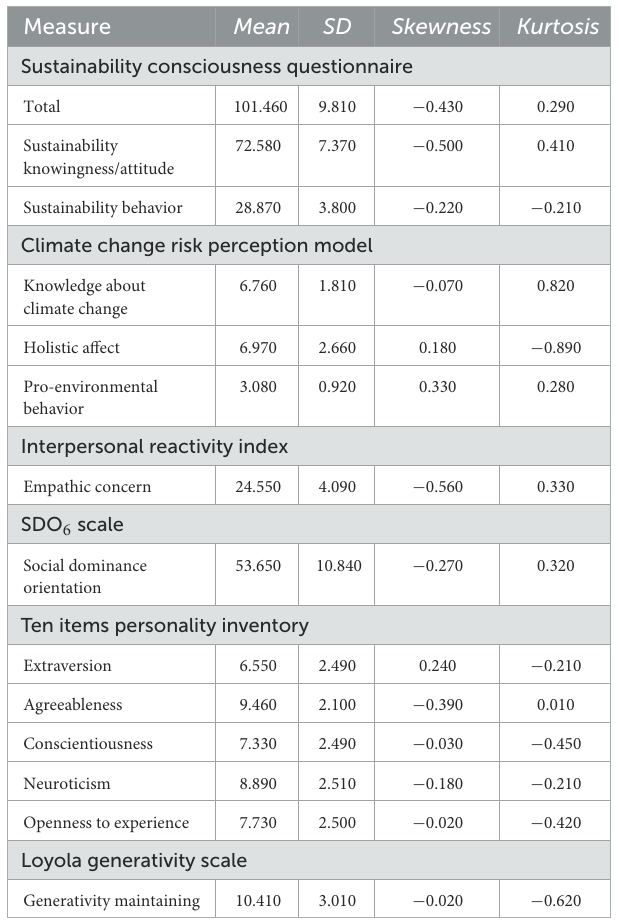
TABLE 5 Descriptive statistics for the scales in Study